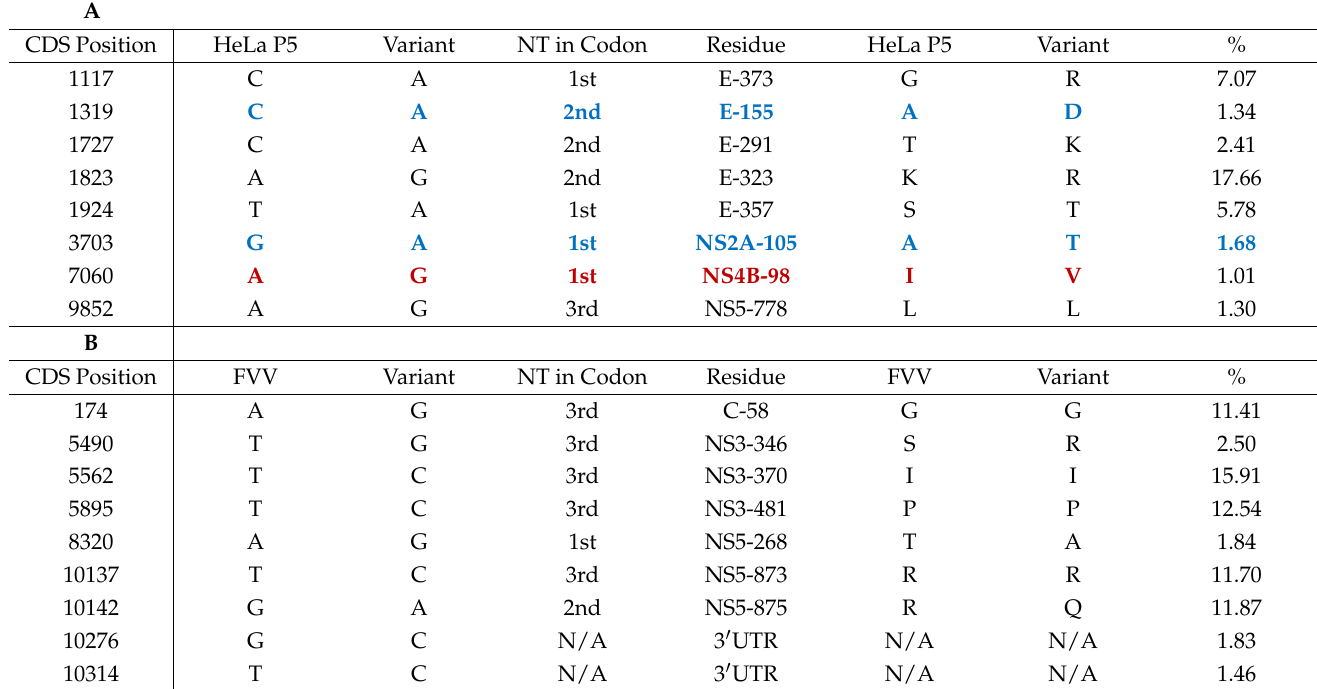
Table 2. Single nucleotide variants (SNVs) for FVV and FVV Hela p5 virus. A : SNVs in FVV HeLa p5. Red denotes residue distinguishing FVV and FNV. Blue denotes residue distinguishing Asibi and Asibi HeLa p6. B : SNVs in